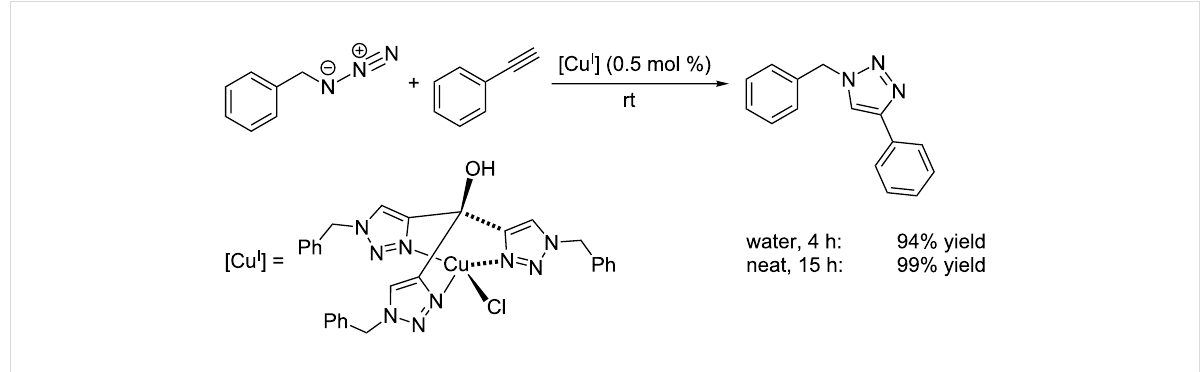
Scheme 7: CuAAC test reaction with chlorido[tris(1-benzyl-1 H -1,2,3-triazol-4-yl)methanol- κ 3 N 3 ]copper(I) and assumed structure of the (pre-)catalyst complex [130].